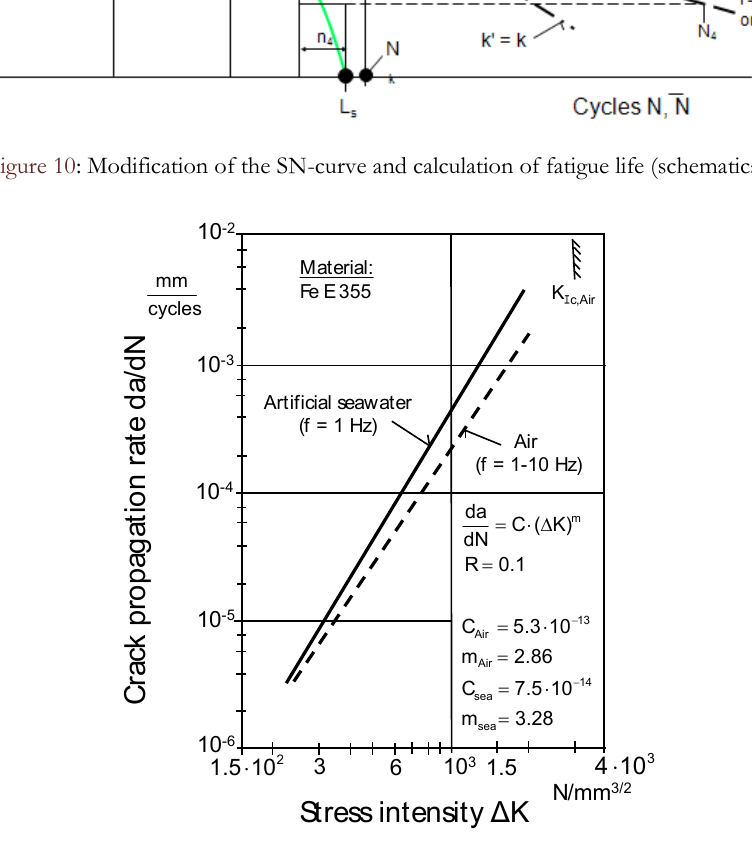
Figure 11: Crack propagation law for steel in air and